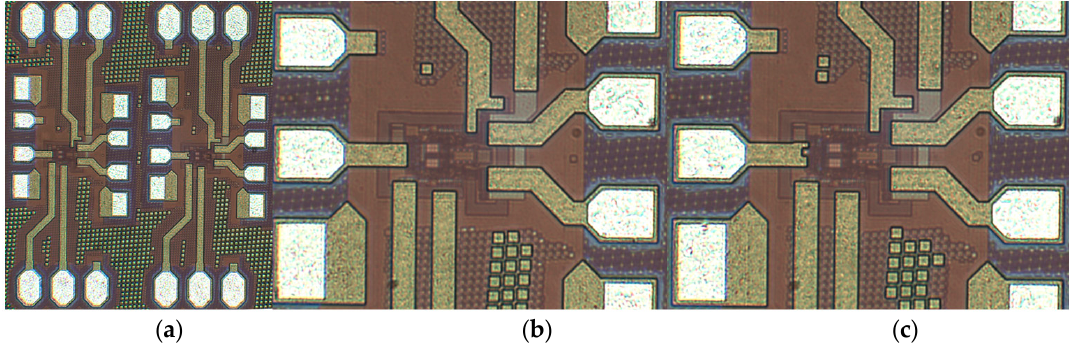
Figure 7. ( a ) Die microphotographs of the overall DVGTIA design 1 and 2 layouts, ( b ) core circuit of DVGTIA design 1 and ( c ) core circuit of DVGTIA design 2.